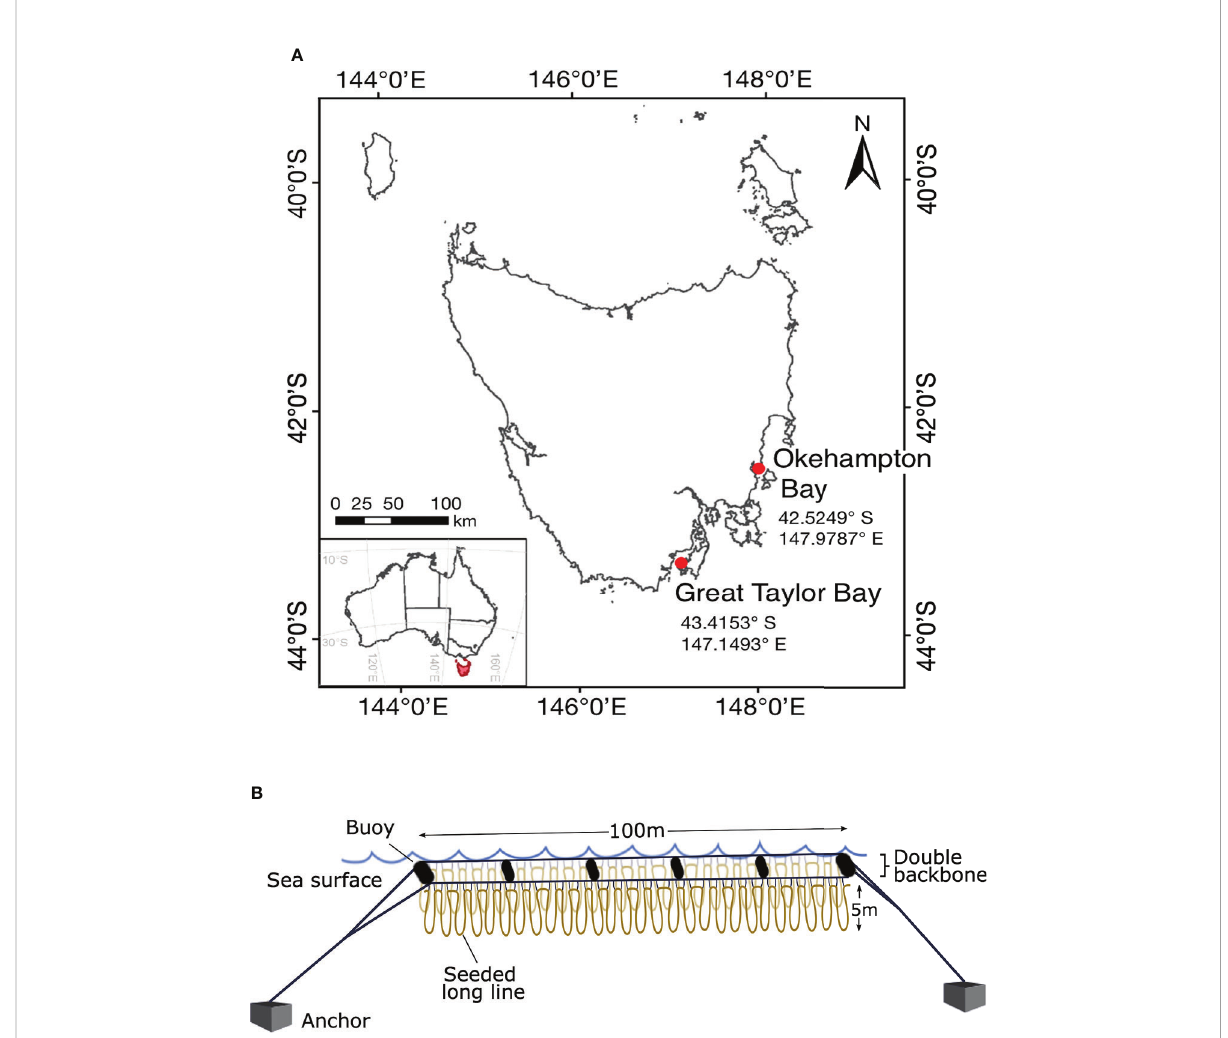
FIGURE 1 Geographic location and study design. Map of Tasmania, Australia, showing (A) the study area of the two farm sites in south-east Tasmania, and (B) the long-line cultivation system replicated (N = 3) at each site where the loops represent the seeded line wrapped around the mussel spat rope attached to the headline with twine. The double backbones are separated by 1.3-m wide